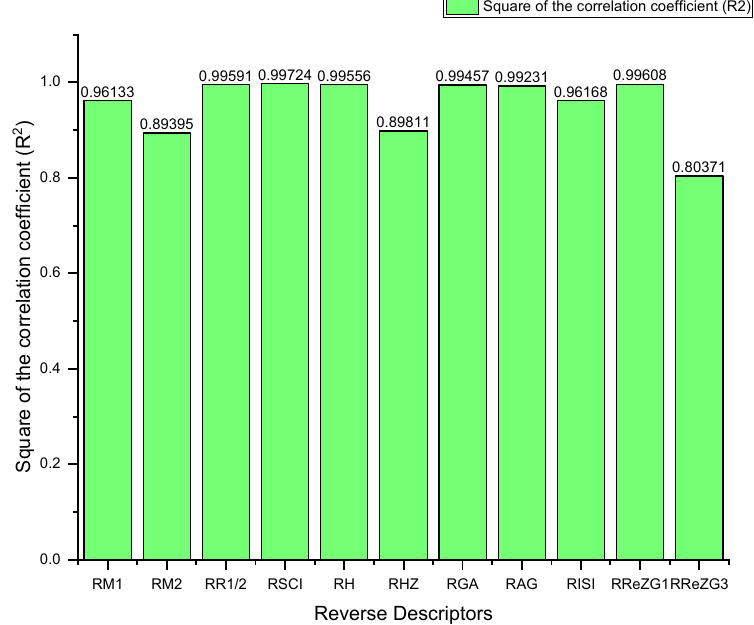
Figure 4. Predictive potential of the reverse topological descriptors via square of the correlation coefficient R 2 .